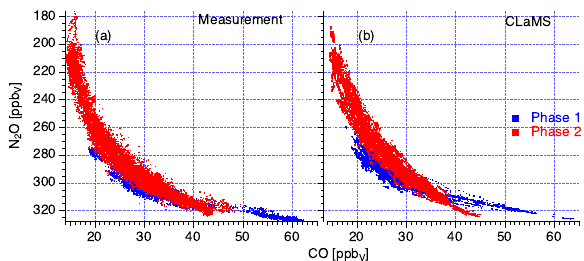
Figure 8. (a) Tropospheric CO fraction from the mass balance equa- tion as a function of N 2 O showing the difference between phase 2 and phase 1. (b) The same as panel (a) but as a distribution over equivalent latitude. Red colours indicate an increase in the tropo- spheric CO fraction.